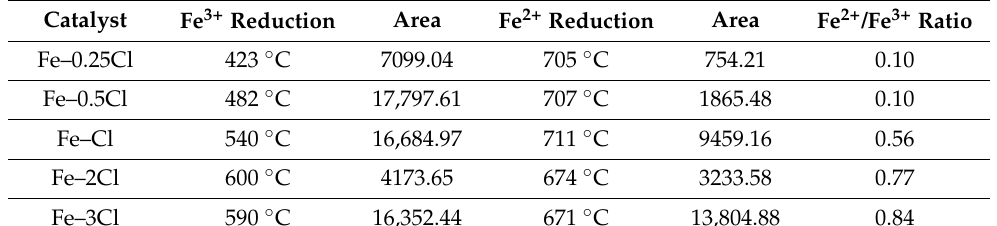
Table 8. Catalyst temperatures and reduction areas.